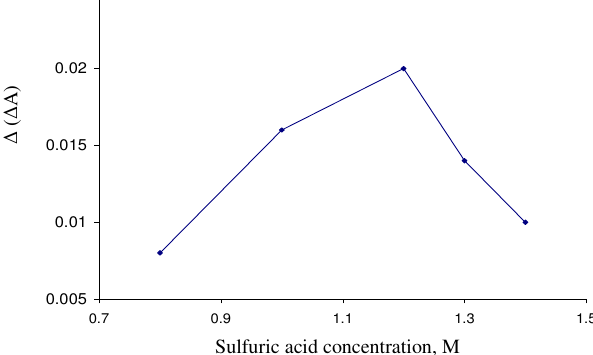
Figure 3. Effect of H SO concentration on the analytical signal. Conditions: Safranin, 2 4 3.4 × 10 −5 M; BrO 3− 2.7 × 10 −3 M; formaldehyde 0.4 µ g/mL, temperature, 28 °C and time